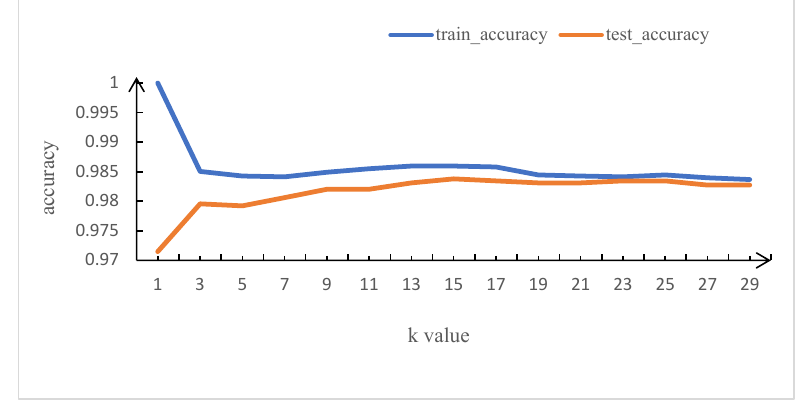
Figure 2. Average training and testing accuracy based on the ARM dataset.